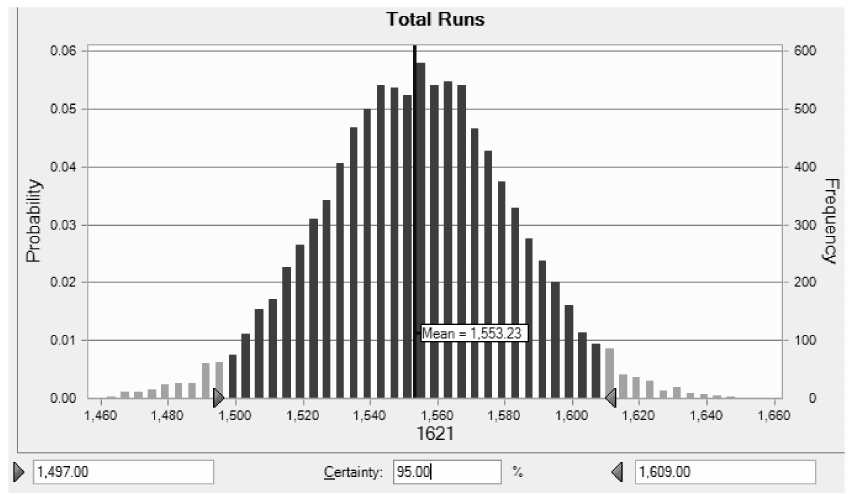
Figure 1. Monte Carlo Simulation for Number of Runs Observed over 10,000 Trials. This graph assumes the DSE based parameters of 3119 returns and a success rate of